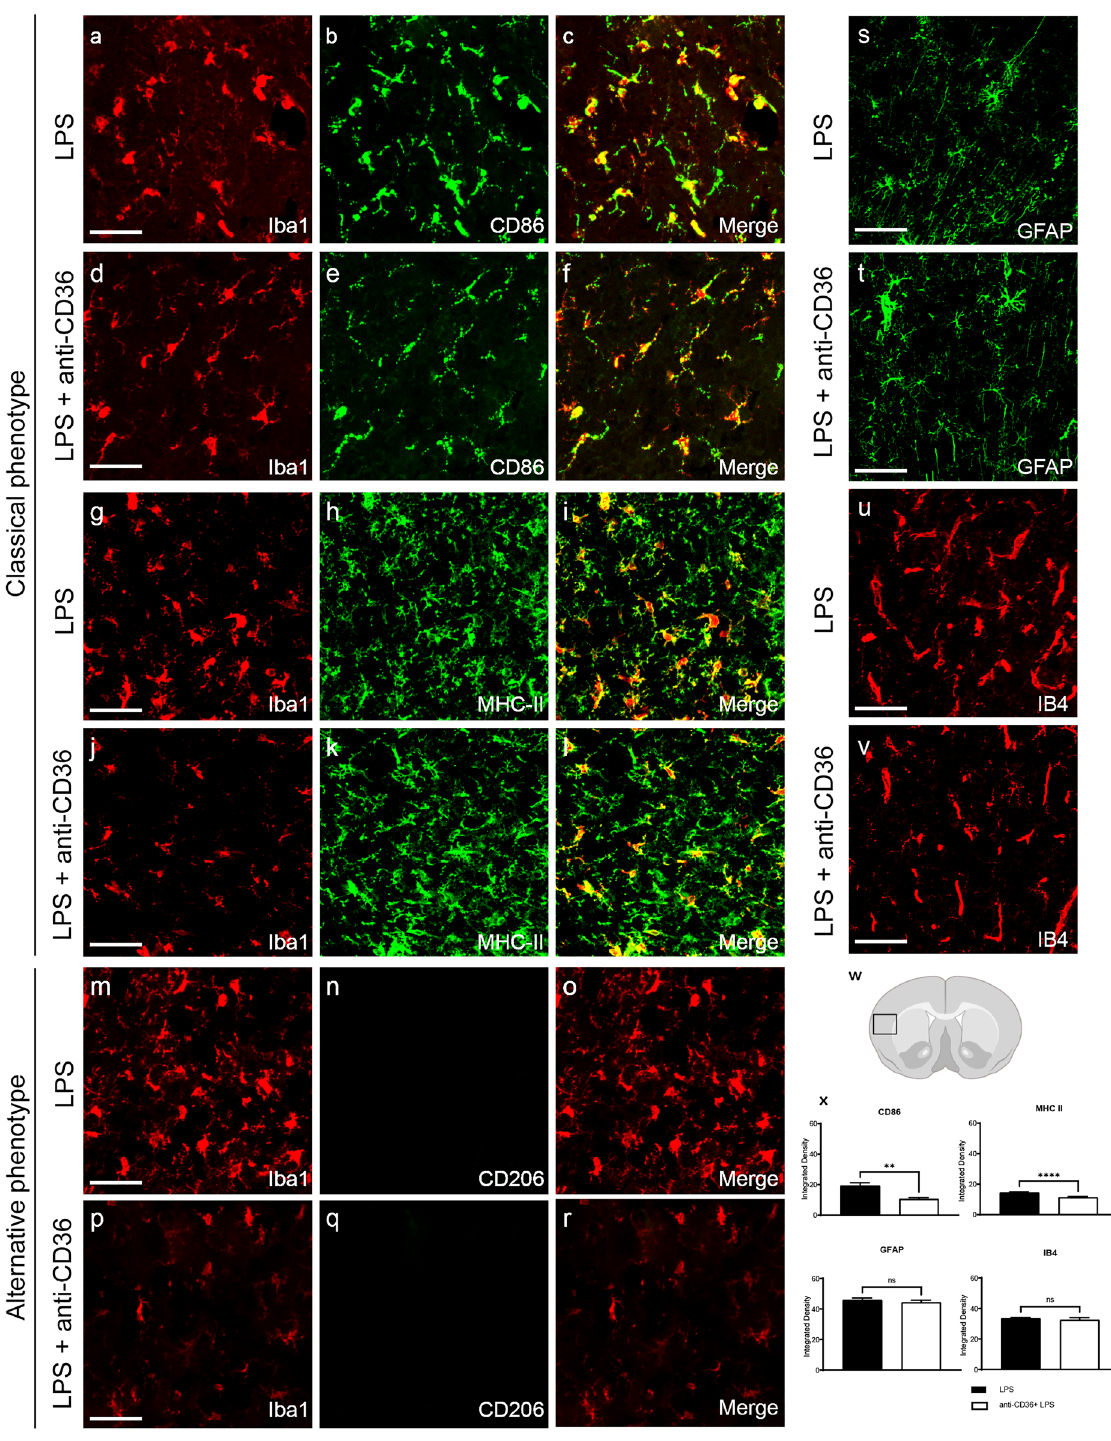
Figure 2. Neonatal microglia demonstrate a reduced classical phenotype when treated with anti-CD36 antibody. ( a – v ) Immunostaining of neonatal brain sections with classical and alternative microglia phenotypic markers ( a – r ), with astrocyte marker GFAP ( s , t ) and IB4 ( u , v ). ( w ) Area of the cortical section analysed and quantification of CD68, MHC II, GFAP and IB4 expression ( x ). Microglial cells (Iba1 +) show increased expression of the classical activation markers CD86 ( a – f ) and MHCII ( g – l ) after systemic LPS injection (x). Their expression is significantly diminished when the pups are pre-treated with anti-CD36 antibody ( d – f and j – l ). Quantification of the signals in arbitrary units shows an overall decrease in expression of the classical markers when the pups are injected with anti-CD36 before the LPS treatment ( x ). Microglia in both the groups did not express the alternative microglial activation marker CD206 ( m – r ). No significant decrease was observed with the astrocytic marker GFAP in LPS and anti-CD36 + LPS treated pups ( s , t , x ). A non-significant decrease in the expression of IB4 is observed in the anti-CD36 + LPS pups when compared to the LPS treated pups ( u , v , x ). Scale bar is 100 µm. Unpaired t test with Welch’s correction ***p ≤ 0.001; **p ≤